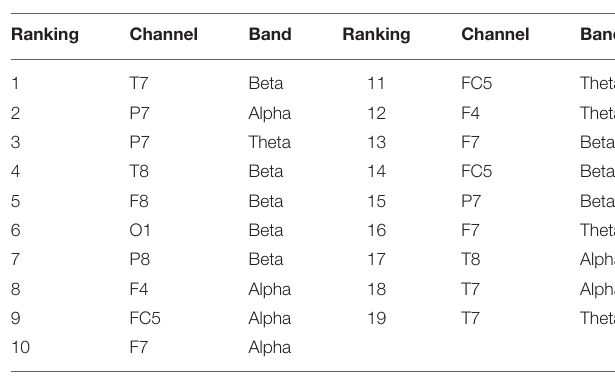
TABLE 4 | Top 19 features after feature selection and weight procedure (FS +